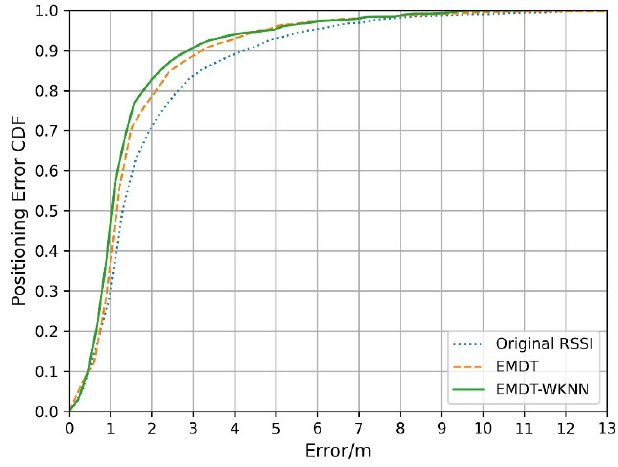
Figure 15. The 75th percentile positioning error for different weeks.